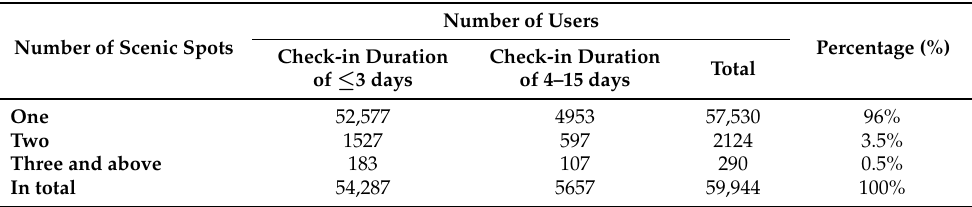
Table 3. Statistics of numbers of scenic spots visited.